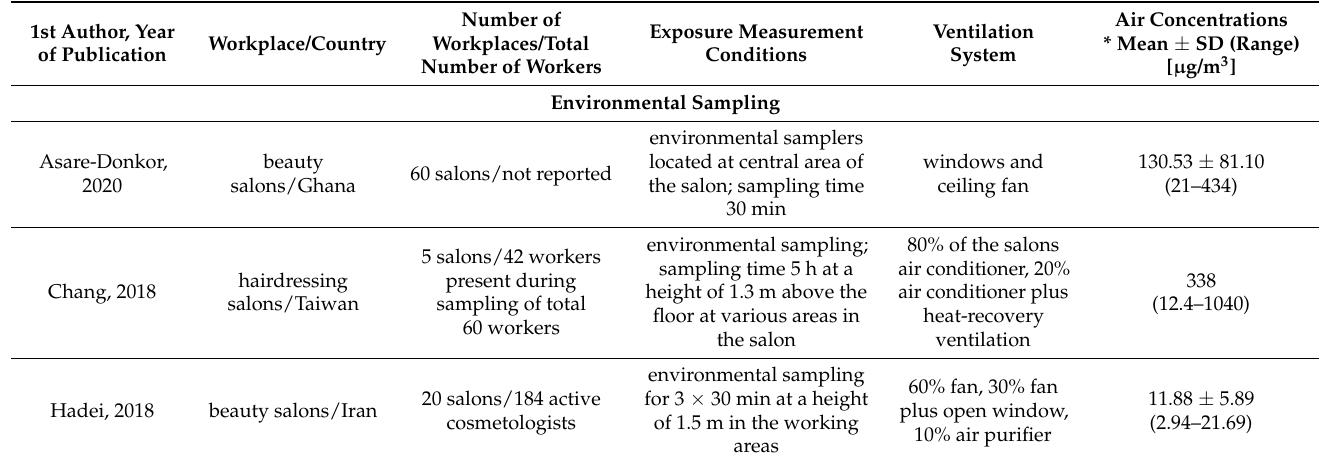
Table 1. Summary of studies investigating formaldehyde air concentrations ( n =